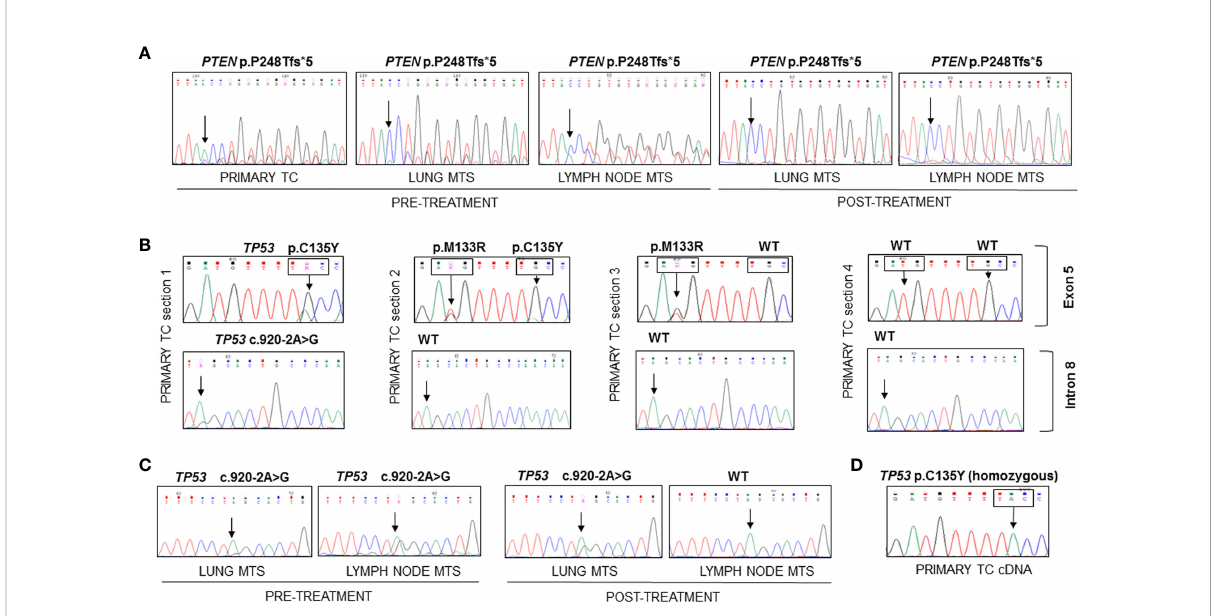
FIGURE 2 Sequencing of the PCR amplicons corresponding to exon 7 of PTEN and to exons 5 and 9 of TP53 genes and of RT-PCR amplicon corresponding to exon 5 of TP53 in FFPE and frozen samples. (A) The PTEN p.P248Tfs*5 mutation was found in heterozygosity in the DNA extracted from FFPE primary TC and lung and lymph node metastases samples obtained before and after Sorafenib treatment. (B) Different mutational patterns observed for TP53 in four sections of primary TC. The fi rst sample showed the presence of TP53 p.C135Y mutation in exon 5 and c.920-2A>G splicing variant in intron 8, the second harbored two TP53 mutations (p.M133R and p.C135Y), the third had only the p.M133R mutant, while the last had no mutations. (C) The c.920-2A>G splicing variant was found in all metastases analyzed with the exception of the lymph node metastasis obtained after Sorafenib treatment. (D) The analysis of TP53 transcript encompassing exon 5 showed the presence of the C135Y mutation in homozygous state in the cDNA obtained from frozen primary TC. TC, thyroid cancer; MTS,